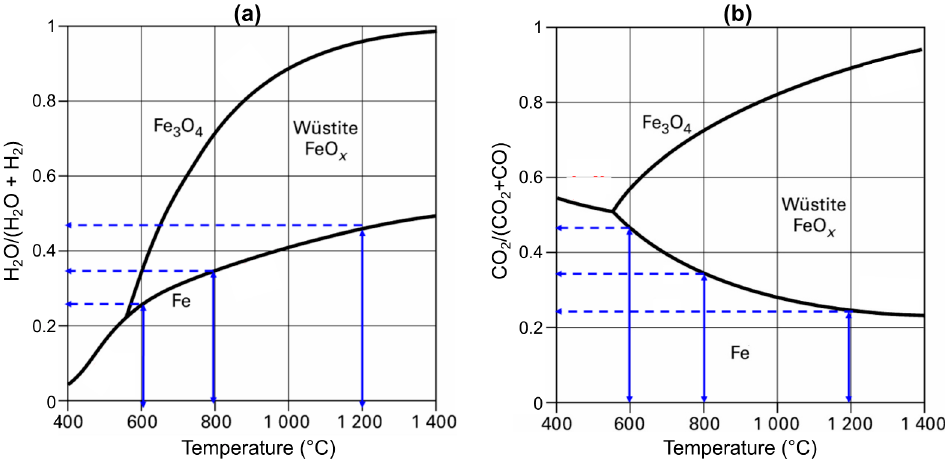
Figure 11. Chaudron (or Baur-Glaessner) phase diagram of the iron phase domains as a function of the temperature and oxidizing power of the gas, ( a ) in the case of a H 2 -H 2 O atmosphere and ( b ) CO-CO 2 atmosphere. The vertical blue arrows represent the driving force for the wustite-to-iron reduction.